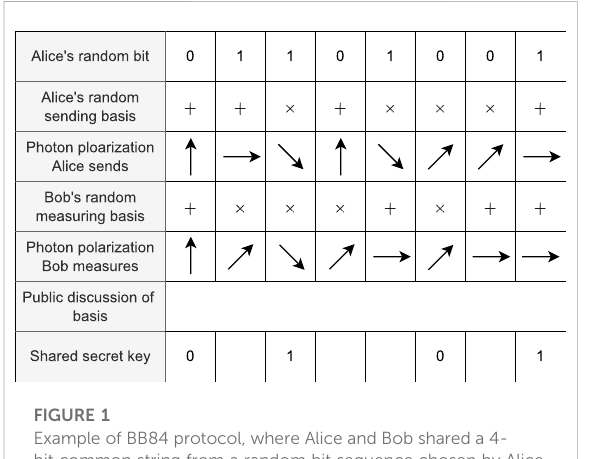
FIGURE 1 Example of BB84 protocol, where Alice and Bob shared a 4- bit common string from a random bit sequence chosen by Alice.